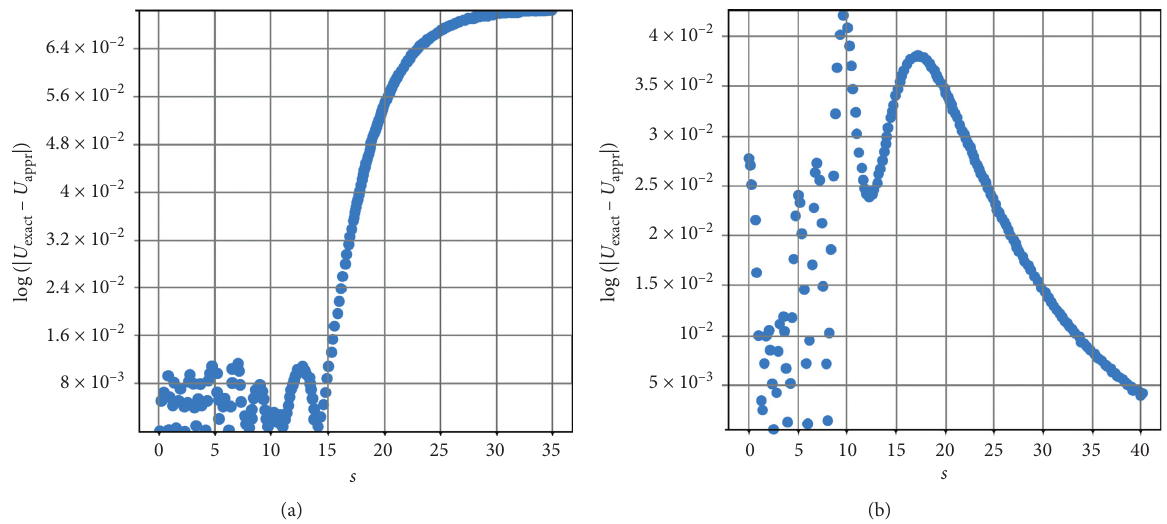
Figure 10: Plots of the convergence and logarithmic absolute error for the solution of Example 3 when the number of hidden neurons is 60 and d t � 1/30. (a) Cost function in each ANN iteration. (b) | U